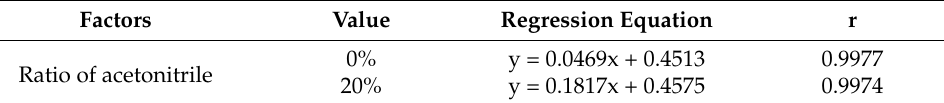
Table 12. Boyd model fitting on the ratio of acetonitrile.